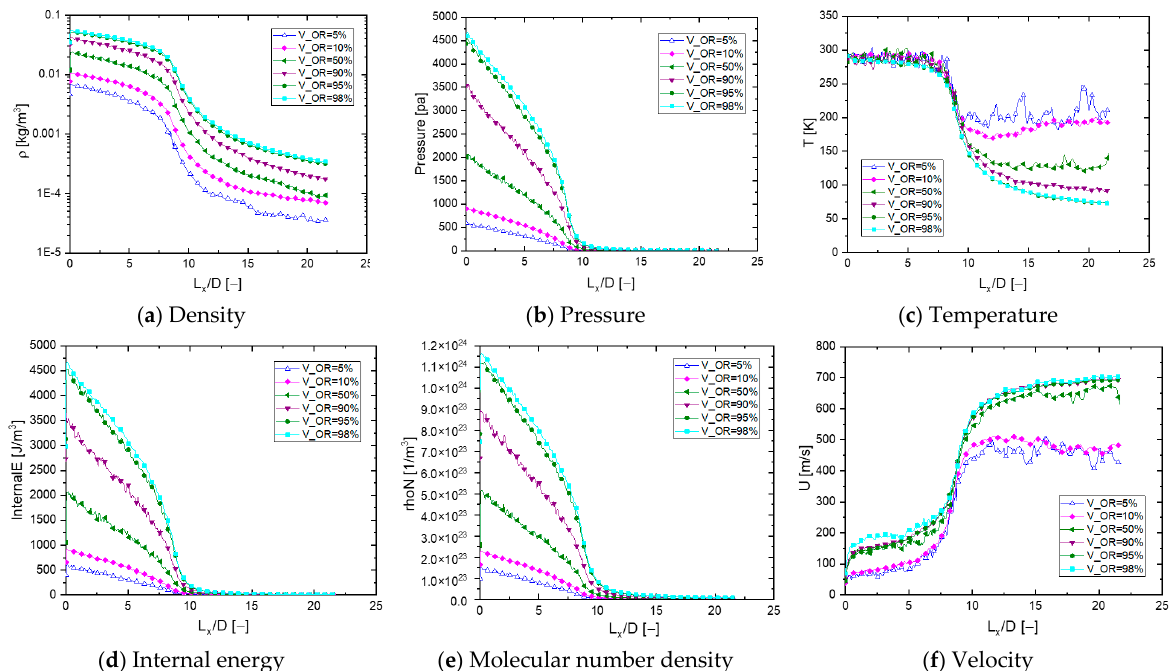
Figure 15. Macroscopic flow parameters at the axial position of the micro ‐ thruster for different nee ‐ valve opening dle valve opening ratios.